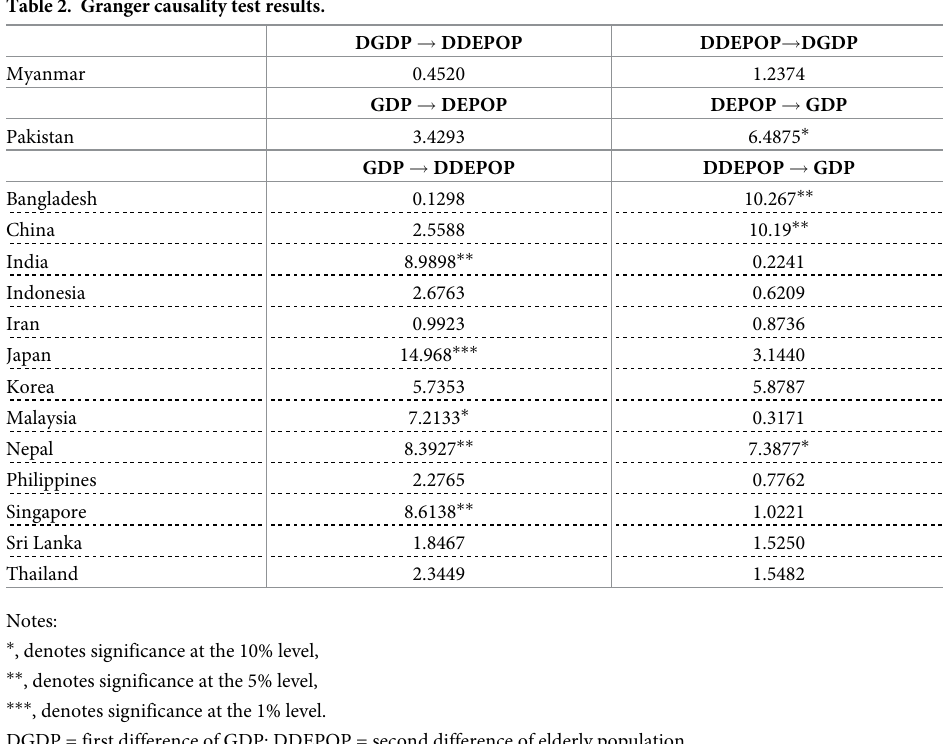
Table 2. Granger causality test results.